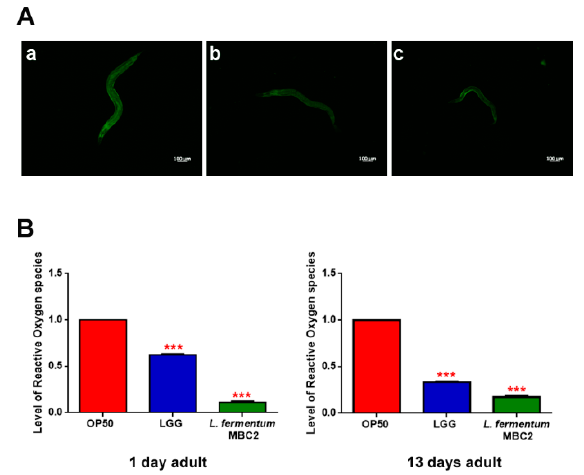
Figure 4. Analysis of oxidative stress in GST4::GFP strain and ROS evaluation. ( A ) Fluorescence microscopy of GST4::GFP worm strain at the stage of 1 day adult fed OP50 ( a ), LGG ( b ) or L. fermentum MBC2 ( c ). Scale bar = 100 µ m. ( B ). Measurement of ROS levels in L. fermentum MBC2-, LGG- and OP50-fed worms at 1 and 13 days of adulthood. Statistical analysis was evaluated by one-way ANOVA with the Bonferroni post-test; asterisks indicate significant differences (*** p < 0.001). Bars represent the